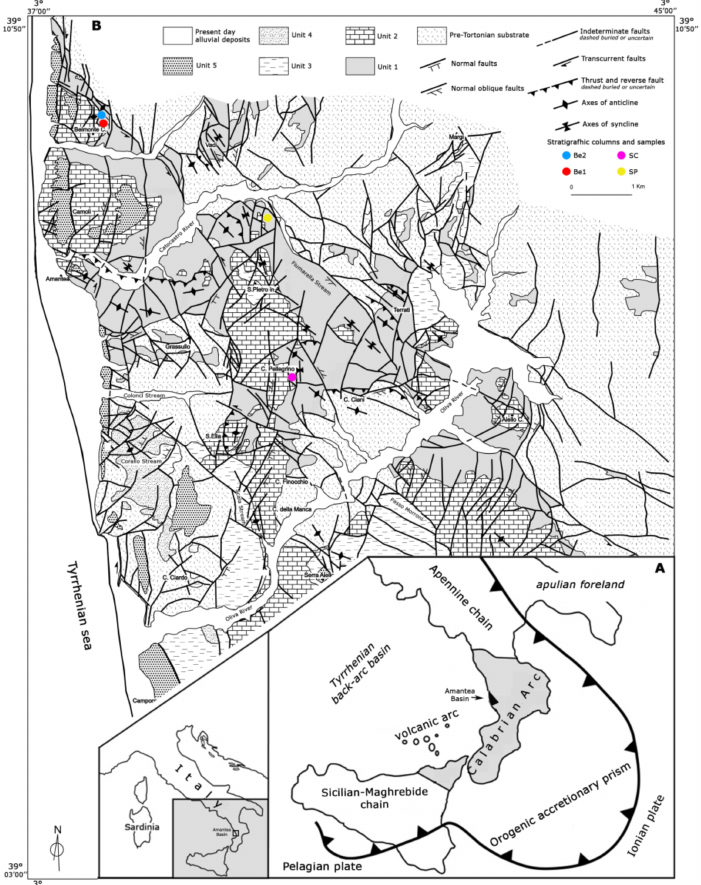
Figure 1. ( A ) Location of the Amantea Basin within the southern Tyrrhenian–Calabrian Arc system and Italy (inset). ( B ) Geological map of the central–northern portion of the Amantea Basin in which the stratigraphic columns and relative sample sites of Figure 2B are indicated (Be—Belmonte; SP— San Pietro; SC—Santa Caterina). The depositional units refer to in [17]. Unit 1 corresponds to the depositional sequence DS1 of Figure 2A. Units 2 and 3 correspond to the depositional sequence DS2 of Figure 2A. Unit 4 corresponds to the sequence DS3 of Figure 2A. For lithological units see Figure 2A. Modified after